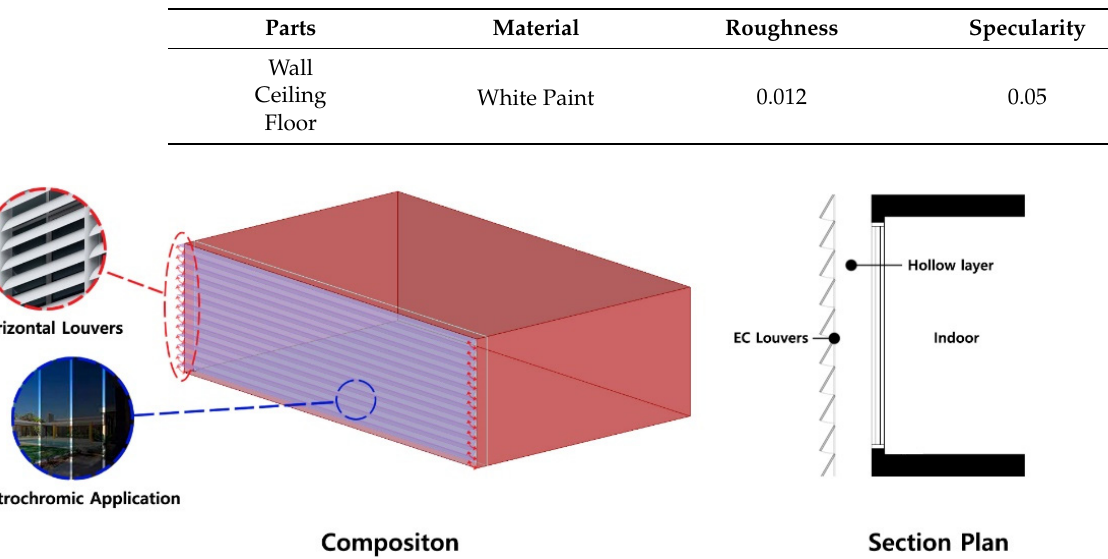
Table 2. Setting the physical properties of interior finishing material.